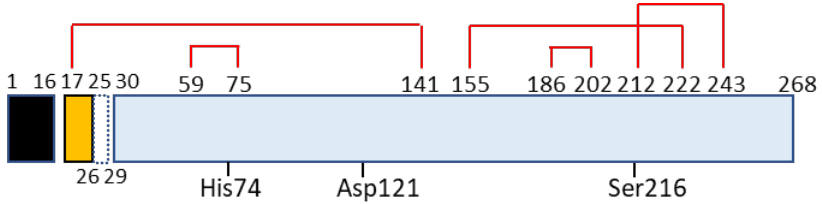
Figure 2. Schematic for domain structure of caldecrin. Black box (signal peptide: amino acid residue number 1–16); yellow box (pro-peptide:17–29 including 26–29 or 27–29 peptide removed by autoactivation); blue box (mature protein: 30–268); red lines (disulfide bridges with cysteine number);